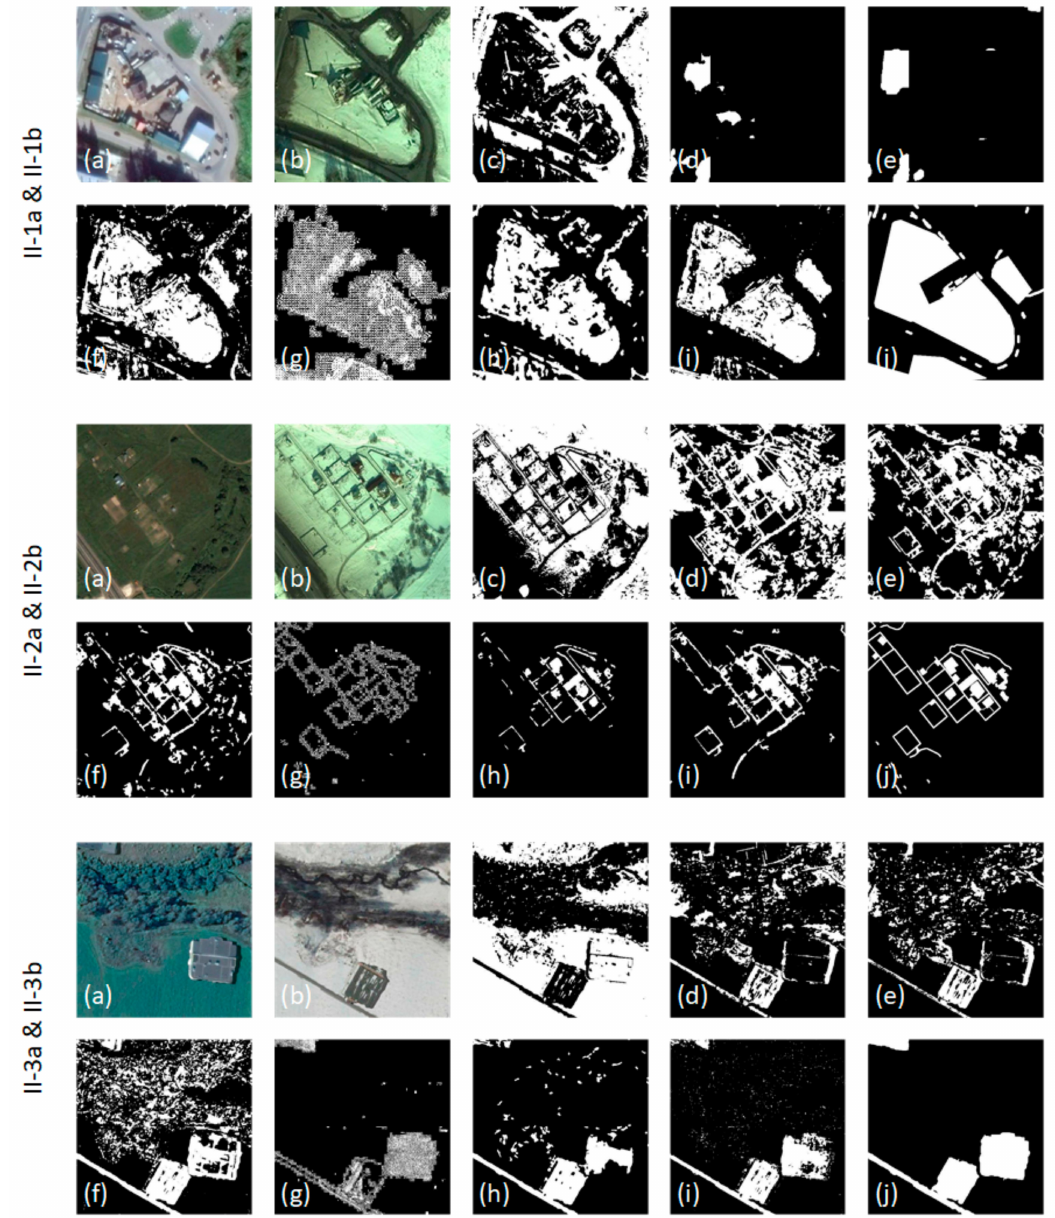
Figure 9. Change detection results of the comparative methods on dataset II: ( a ) pre-event image, ( b ) post-event image, ( c ) CVA, ( d ) GETNET, ( e ) PCANet, ( f ) GAN, ( g ) DSCN, ( h ) DLSF, ( i ) our PDA, ( j ) ground